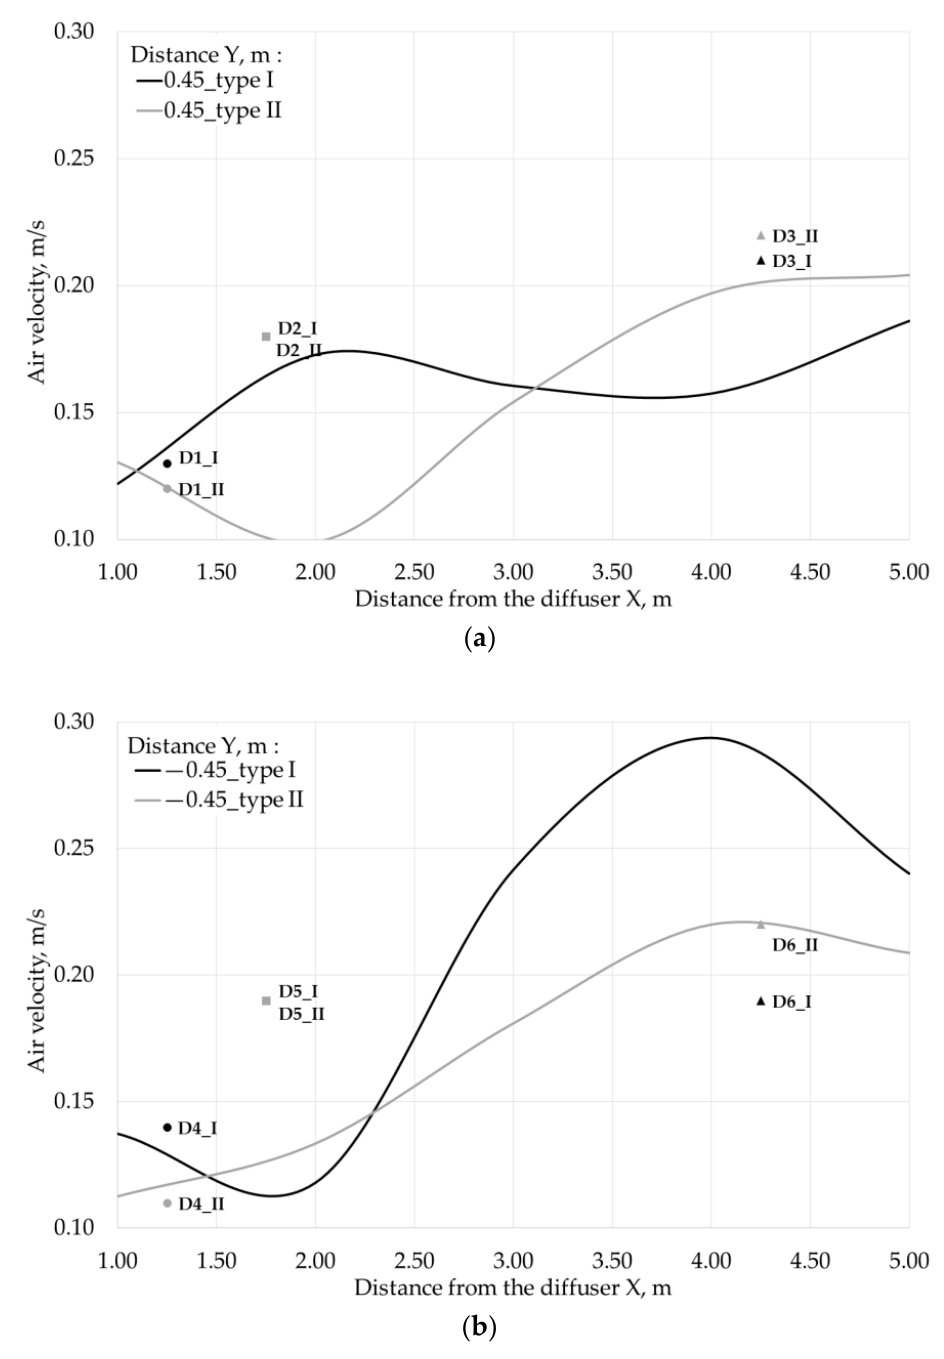
Figure 7. Distribution of the air velocity with the distance from the diffuser for Type I and Type II at the height of Z = 1.70 m (for lines) and Z = 1.20 m (for points) for: ( a ) Y = 0.45 m and desk D1 – D3; ( b ) Y = − 0.45 m and desk D4 – D6.